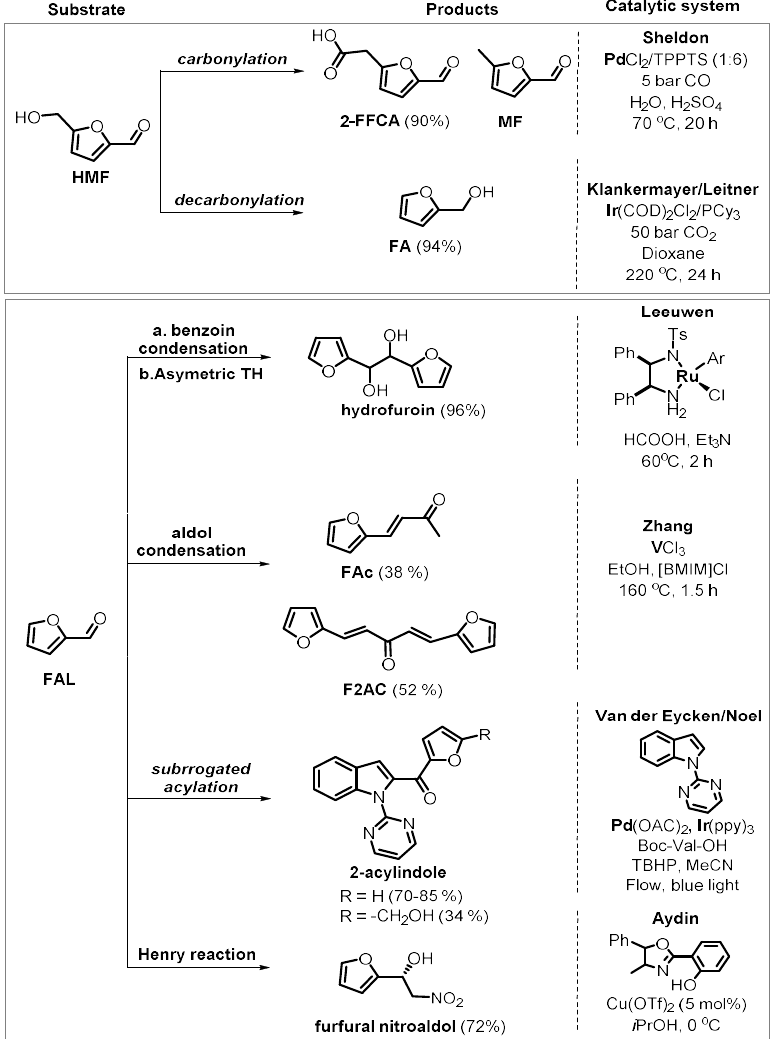
Figure 10. Biomass derived furanic-based intermediate for drugs syntheses. The decarbonylation/reduction of HMF was explored by Klankermayer and Leit- ner [209]. The reaction was carried out with a catalytic system IrCl(cod) 2 (cod=1,5- cyclooctadiene) as the metal precursor in the presence of a phosphine ligand (PCy3) in boiling 1,4-dioxane resulting in 41% conversion with 97% selectivity towards DHMF after 48 h. Interestingly, the addition of CO 2 increased the conversion up to 99%, suppressing the formation of humins. The substitution of solvent with THFA converted all the mixture into a single product stream of